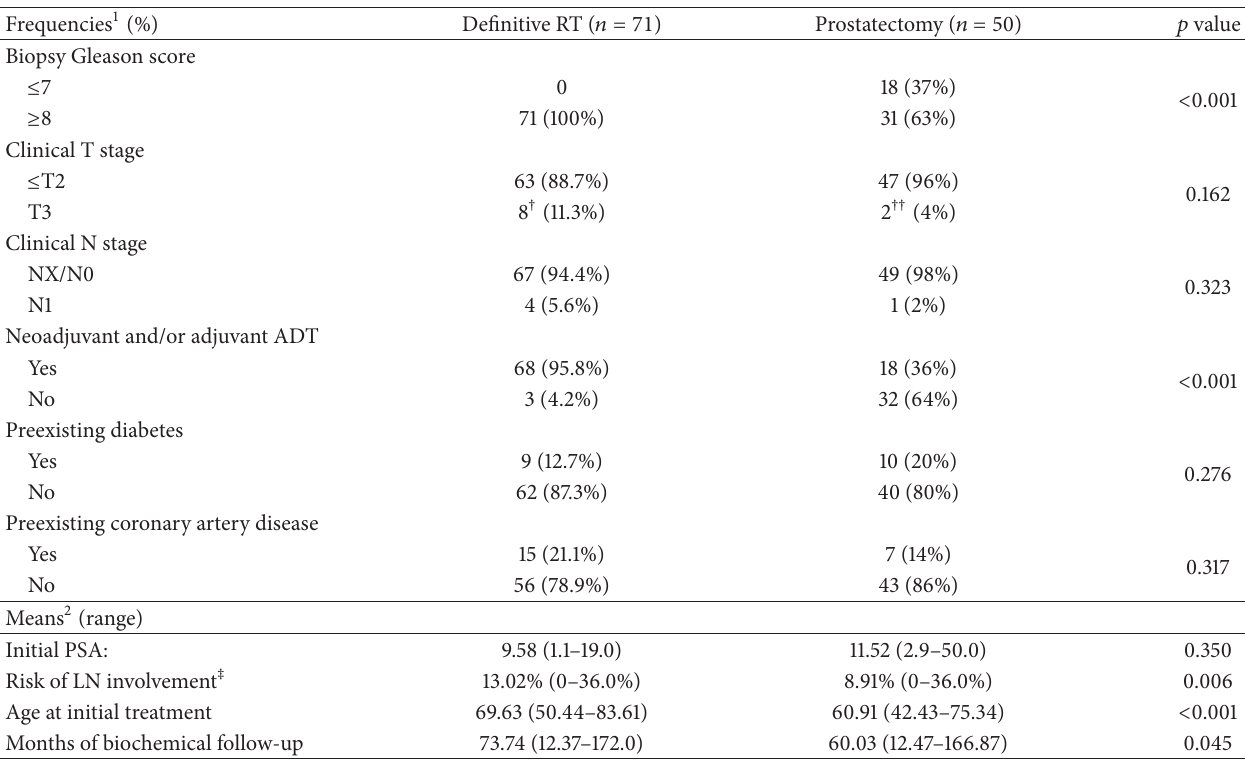
Table 1: Pretreatment and treatment characteristics.